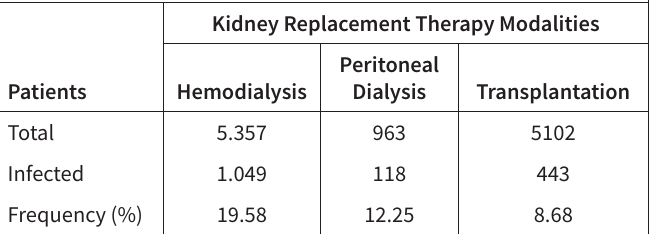
Table 1. Numbers and Frequencies of Coronavirus Disease 2019 in Kidney Replacement Therapy Patients